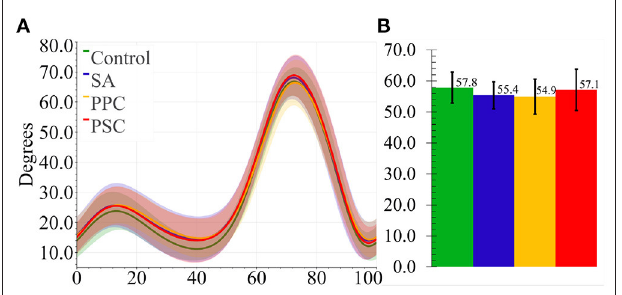
FIGURE 6 | (A) Average knee angles for all four braces. The shaded region represented 1 SD. (B) Average knee range of motion for all braces. The ticks represent 1 SD.